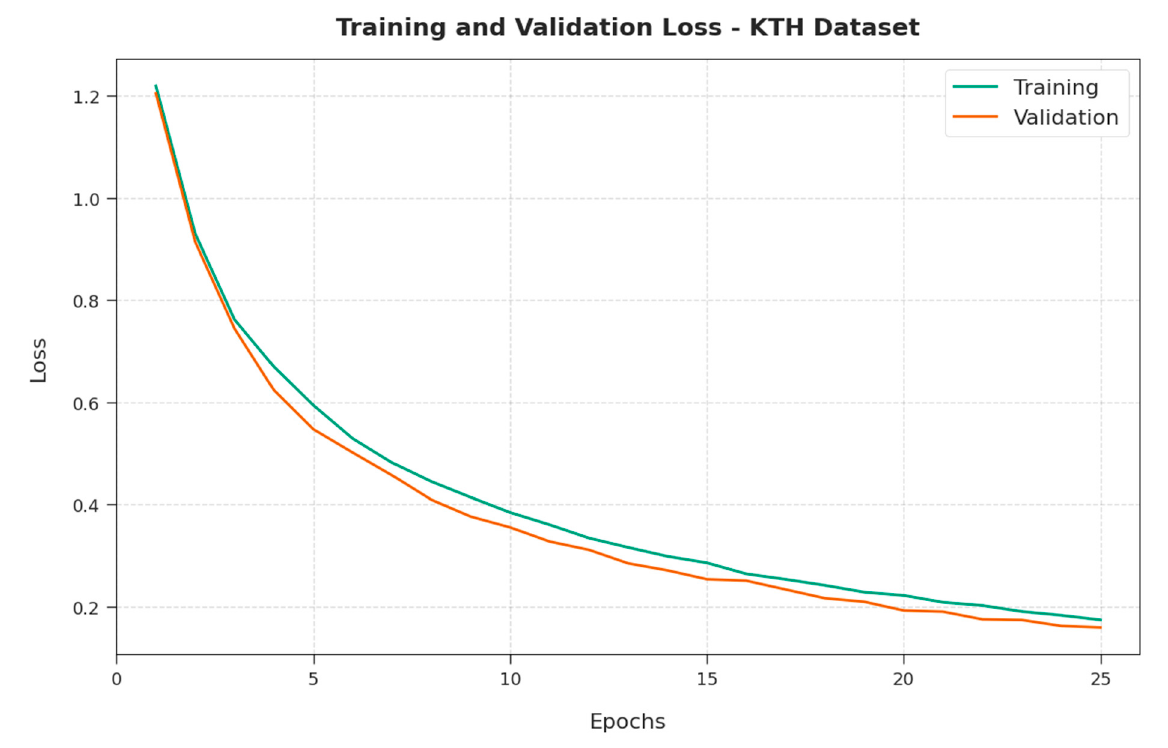
Figure 5. Training and validation losses of QWSA-HDLAR model on KTH dataset.